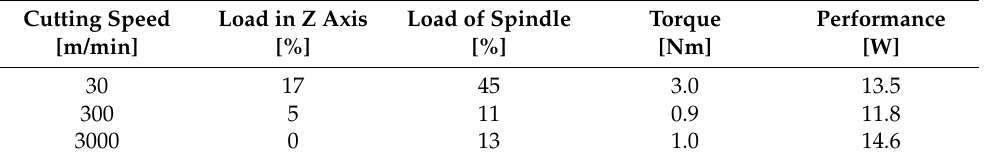
Table 3. Recorded values of observed parameters during machining of zirconia.